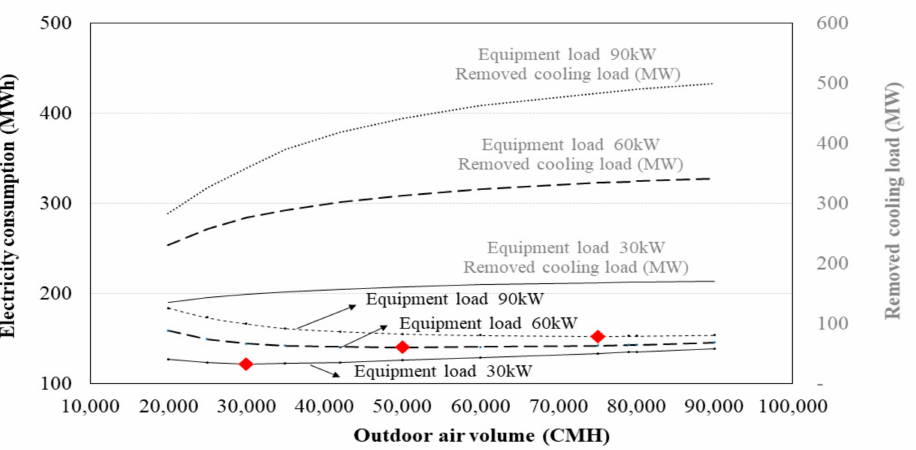
Figure 10. Variations in the annual electricity consumption with the design air volume by equipment load.